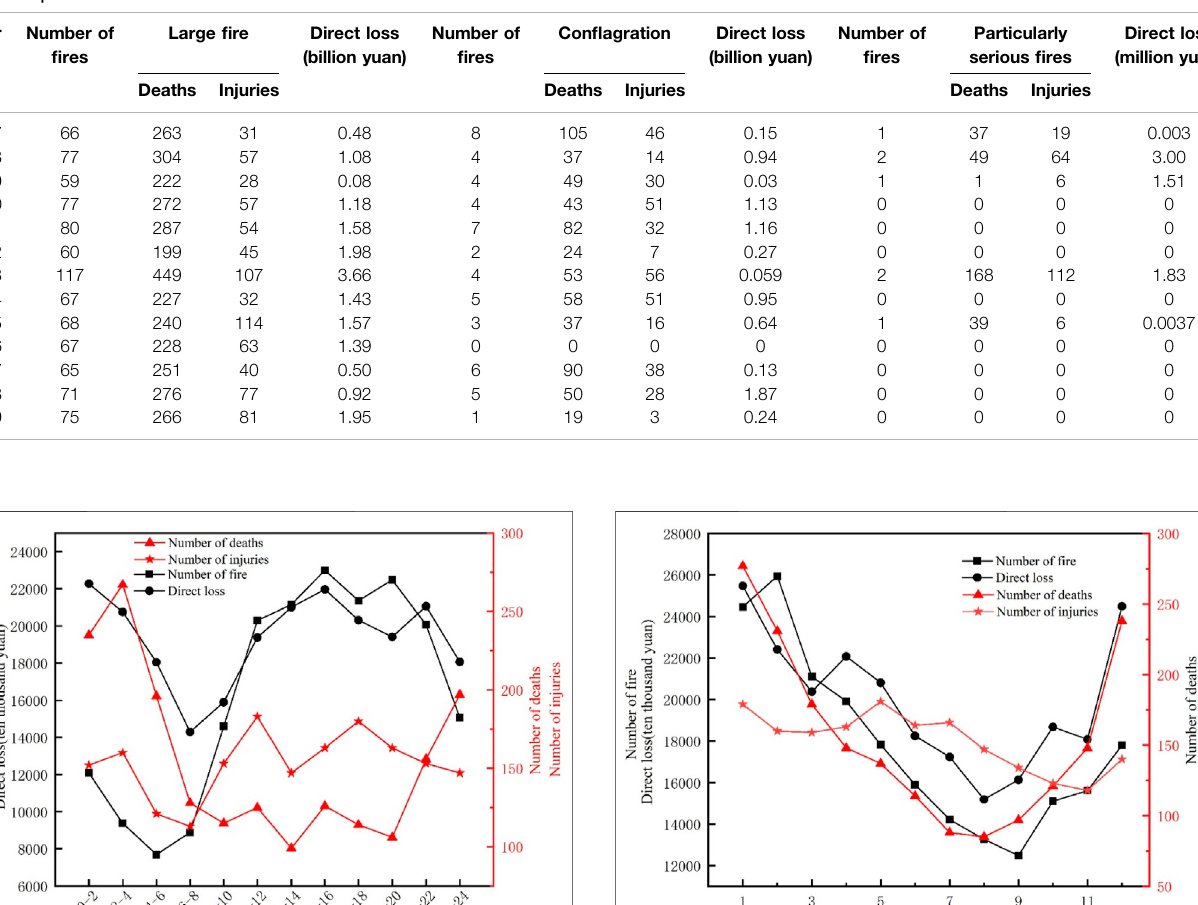
TABLE 5 | Details of the different levels of serious fi res from 2007 to 2019.